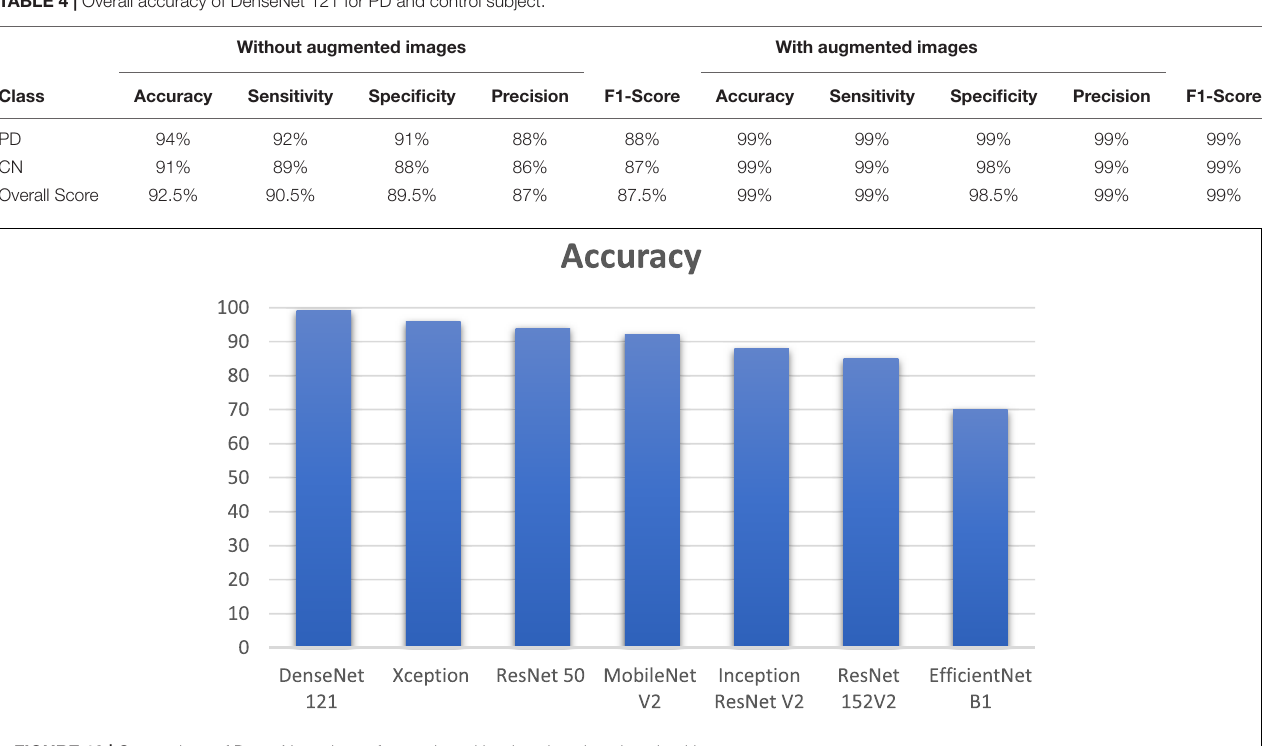
FIGURE 13 | Comparison of DenseNet using soft attention with other deep learning algorithms.